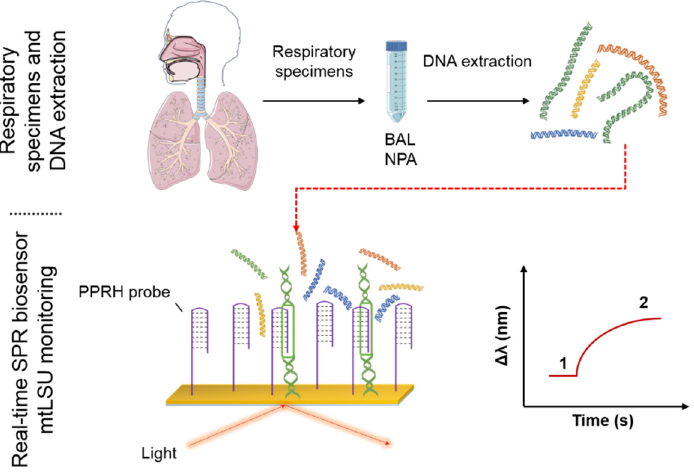
Figure 1. Surface plasmon resonance (SPR) biosensor methodology for the specific detection of P. jirovecii . The samples (BAL and NPA) after DNA extraction were injected to the SPR device in which the PPRH probe is attached above the gold surface of the sensor. Wavelength variation of the reflected light is directly related to the amount of the analyte bounded to the bioreceptor. (BAL: bronchoalveolar lavage, NPA: nasopharyngeal aspirates, PPRH: polypurine reverse-Hoogsteen hairpin, 1: Wavelength correspond to the baseline, 2: Wavelength correspond to target analyte recognition).